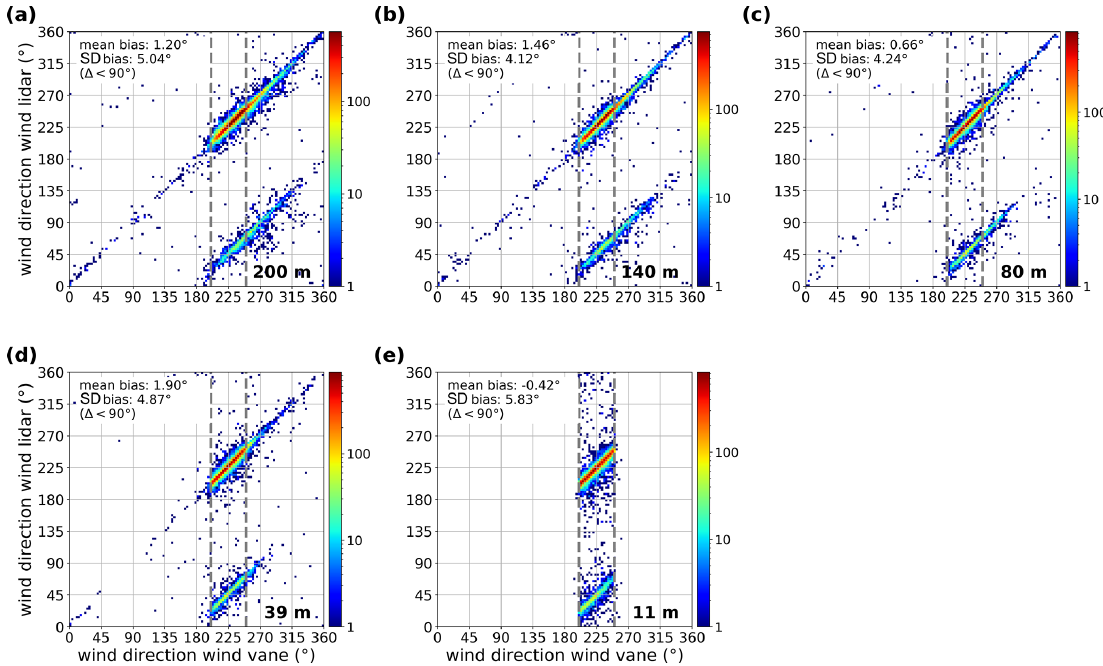
Figure 11. Wind direction comparison between wind lidar and mast data for the different heights: (a) 200m, (b) 140m, (c) 80m, (d) 39m and (e) 11m. The mean bias and standard deviation in the bias are indicated in each panel, taking into account only data for which the deviation is less than 90 ◦ . Note that the selected wind sector of 200–250 ◦ is based on the 10m wind.